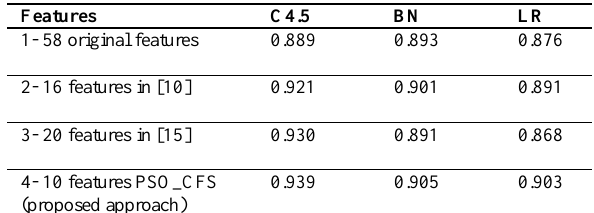
Table 6. AUC results of DSO + Classifiers with different set of